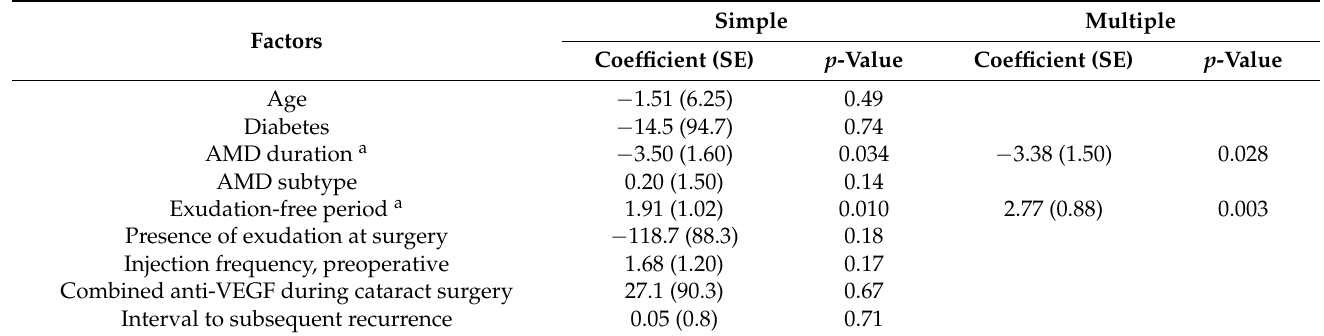
Table 3. Analysis of prognostic factors associated with the interval of postoperative anti-VEGF